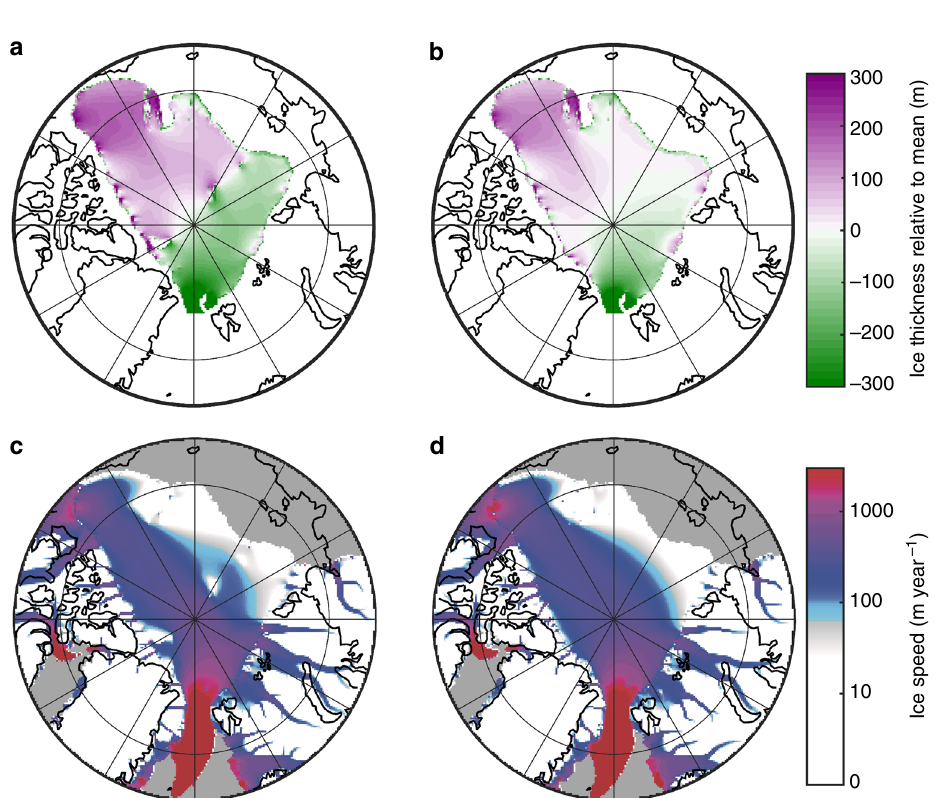
Fig. 5 Impact of Lomonosov Ridge buttressing on ice shelf dynamics. a , c are the same as simulations shown in Fig. 3b, b , d is an identical simulation with the Lomonosov Ridge removed, location of Lomonosov Ridge is shown in Fig. 1a. The mean shelf thicknesses are comparable between the simulations (1070 and 1029m for a and b ,